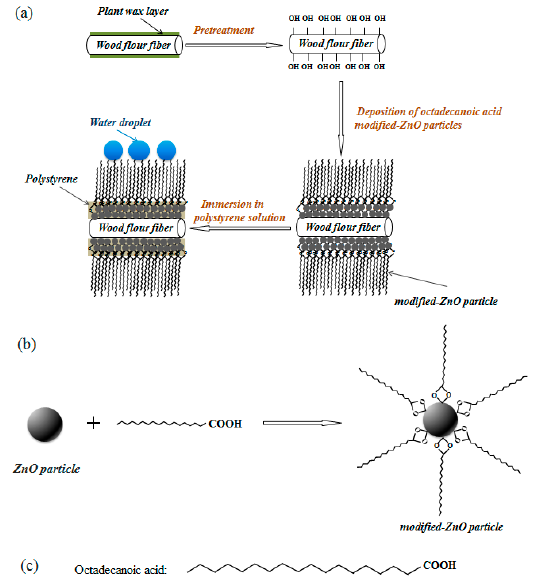
Figure 1. ( a ) Synthesis route for the preparation of superhydrophobic / superoleophilic wood flour. ( b )GraphicalrepresentationforthemodificationoftheZnOparticlewithoctadecanoicacid. ( c )Chemical structure of octadecanoic